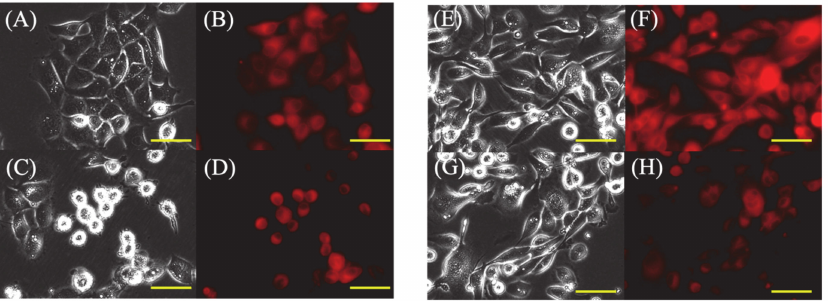
Figure 2. Fluorescence microscopic images of 5-ALA-induced protoporphyrin IX (PpIX) in HDC and LuBi cells. ( A – D ): HDC cell. ( E – H ): LuBi cells. ( A , C , E , G ): Bright field images. ( B , D , F , H ): PpIX fluorescence images. ( A , B , E , F ): PDT ( − ). ( C , D , G , H ): PDT (+). The HDC and LuBi cells were then incubated with 1 mM 5-ALA for 4 h (PDT ( − )). After changing the medium, the cells are irradiated with an LED light source light (630 nm, 20 mW/cm 2 , 10 J/cm 2 ) (PDT (+)). Cells were imaged using a fluorescence microscope 10 min after irradiation. In PDT (+) cells, approximately half of the HDC cells showed a rounded morphology in the medium, but many LuBi cells were still attached to the dish bottoms. PpIX fluorescence in each primary tumor cell type was photobleached. Bars = 50 µ M. In PDT (+) cells, approximately 50% of HDC cells showed a rounded